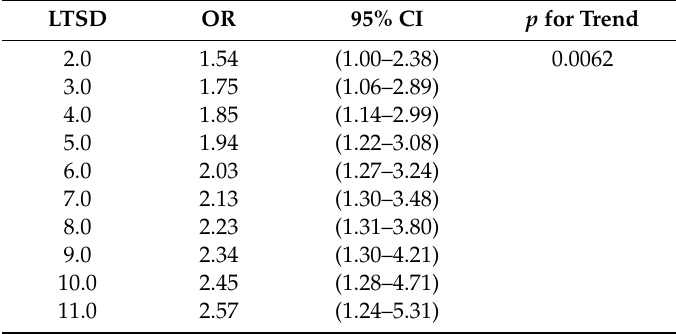
Table 5. OR and 95% CI for the restrictive cubic spline of hypertension.